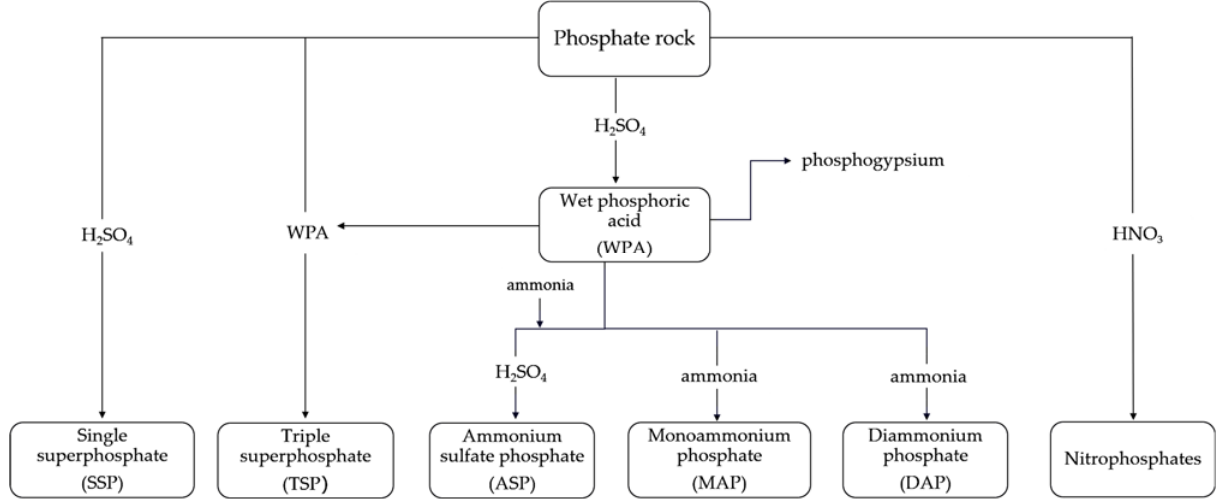
Figure 3. Relationship between the phosphate rock and the phosphate fertilizers [3].